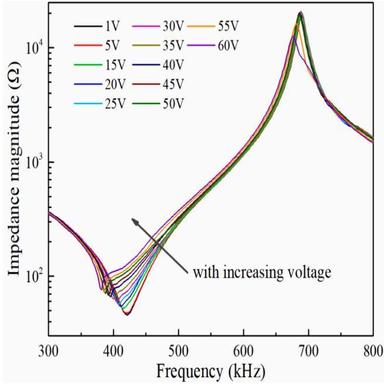
Thickness-resonance impedance spectrum of the PMN-PT composite disk under different AC driving voltages.